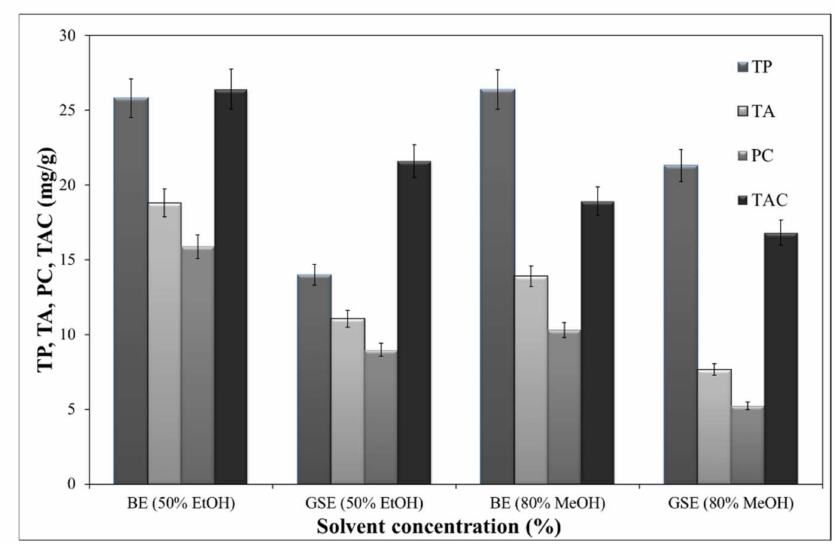
Figure 9. Correlation between TP, TA, PC, and